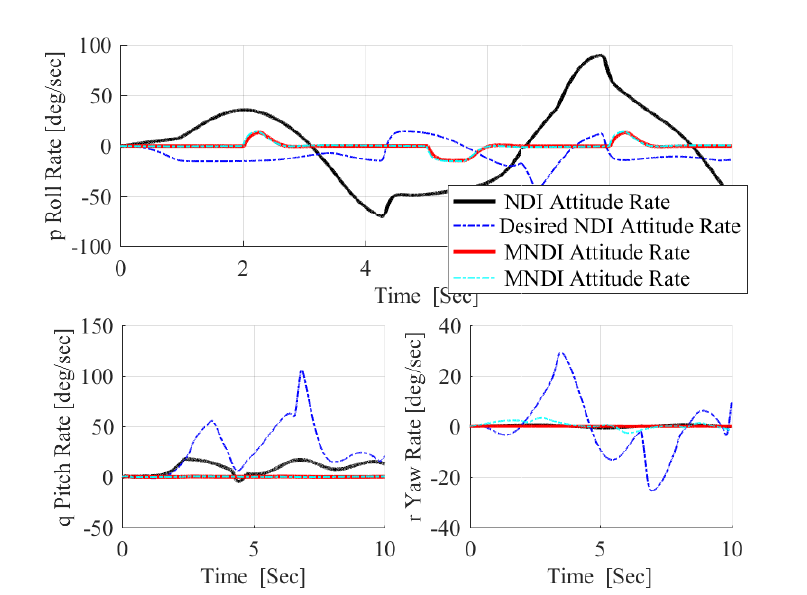
Figure 15. Attitude angle error for outer roll angle excitation with wind and